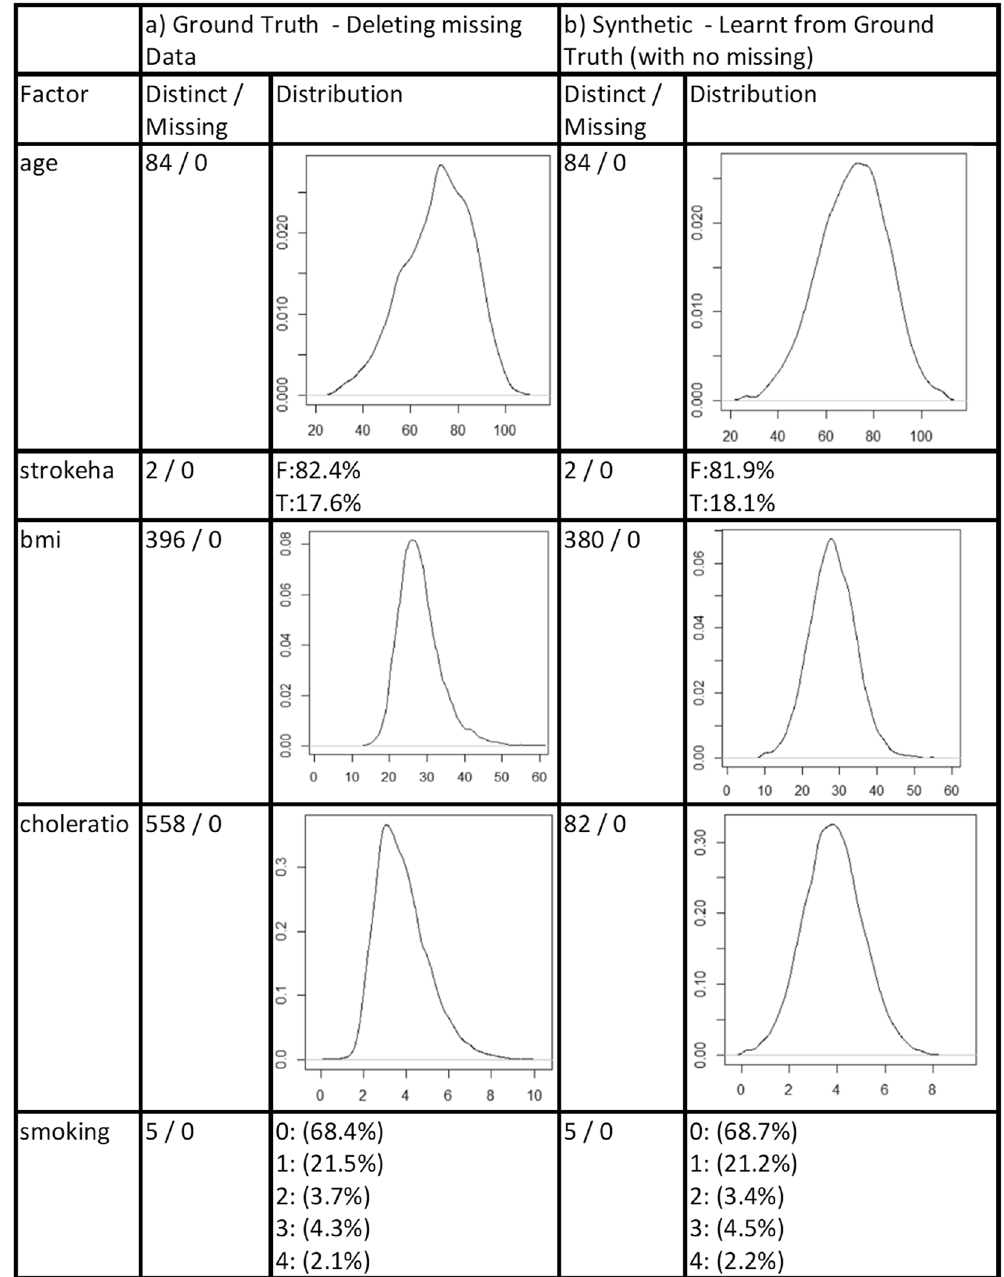
Fig. 2 Plots of sample distributions and statistics of the original ground truth data when all missing data are deleted along with plots, distributions, and statistics from the synthetic data that are generated using a BN inferred from the ground